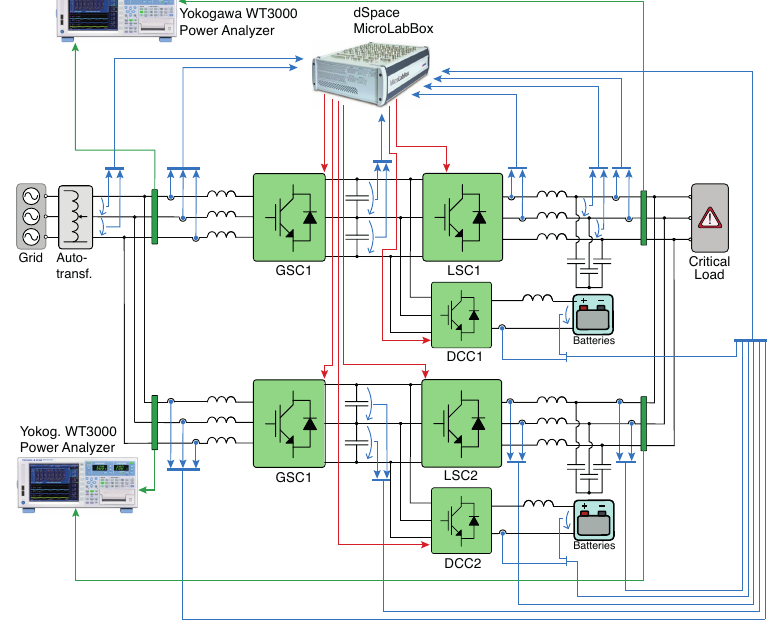
Figure 7. Schematic representation of the laboratory